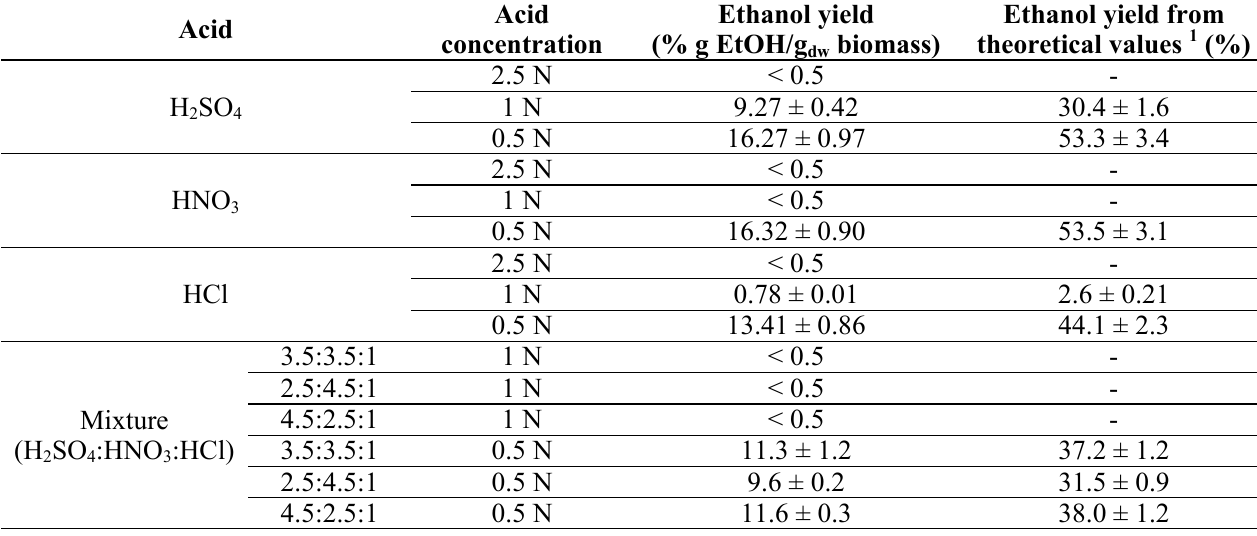
Table 1. Bio-ethanol production from the hydrolysates from A. platensis . The duration of fermentation was 24 h. n = 9, ± SD.